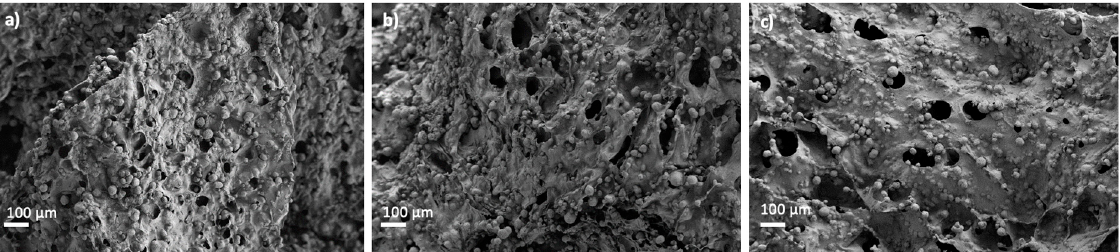
Figure 7. SEM pictures of Alg 6%, HA 24%, CaCl 2 1M1h GA aerogels after bioactivity test. Aerogels were left in SBF medium for ( a ) 3, ( b ) 7 and ( c ) 15 days.